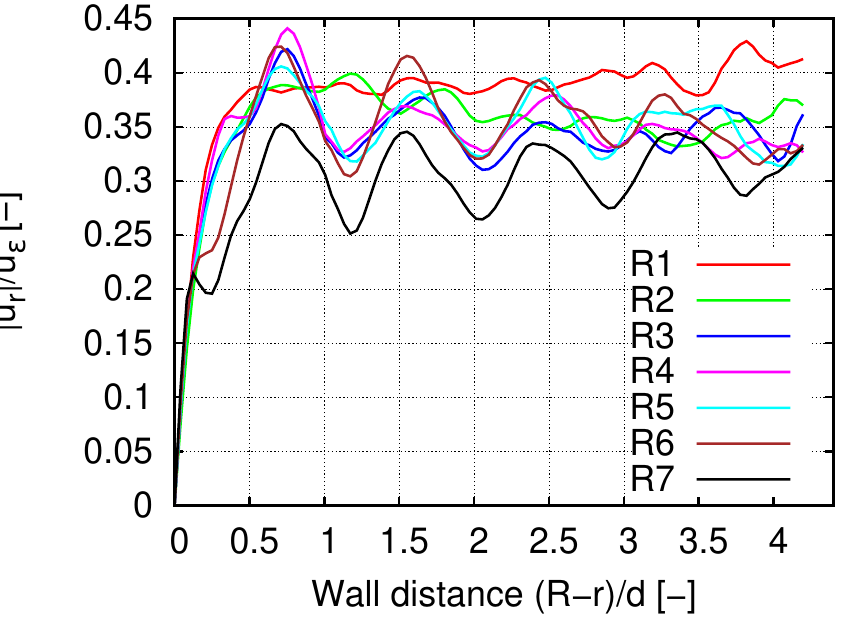
Figure 10. Averaged (circumferential and over the bed height) magnitude of the radial velocity component u r . A significant increase for configurations with wall structure can be observed compared to R7 (plain